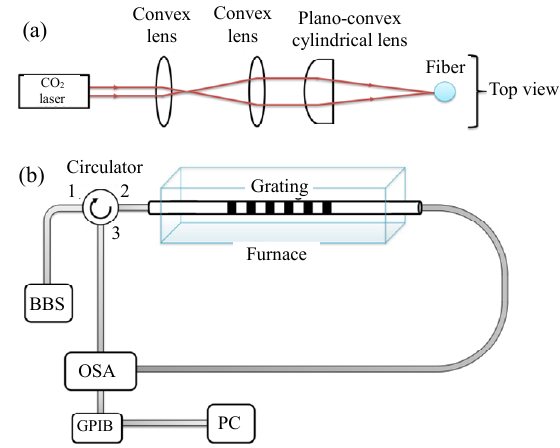
Fig. 1 Schematic diagram of: (a) CO 2 laser annealing treatment and (b) fiber thermal annealing using high temperature furnace for regeneration process and durability